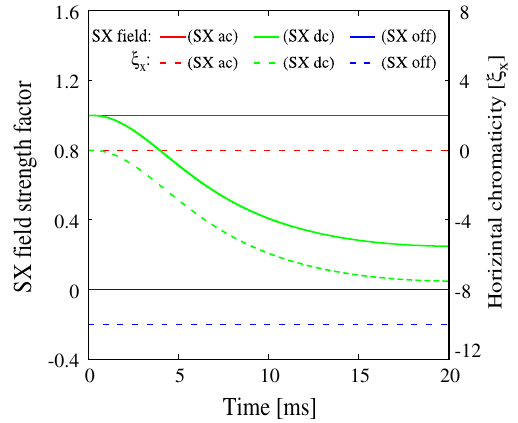
FIG. 10. SX field strength factor and chromaticity ξ x as functions of the beam acceleration time in the RCS. The situation is the same for ξ y